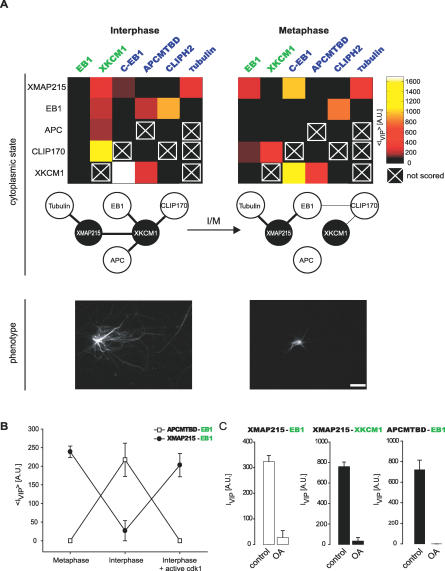
Change in the MAP Interaction Network at Interphase/Metaphase Transition(A) Pairwise interaction of MAPs in interphase and metaphase are represented as color-coded tables (upper panel). The color code corresponds to <IVIP> of at least three different microscopic fields. Proteins in green are EGFP tagged, and those in blue are Cy5 labeled. Below each table is a schematic representation of the network states in interphase and metaphase. Line thickness corresponds to interaction strength normalized to the strongest signal detected in interphase or metaphase. In the lower panel, an interphase aster is shown on the left and a mitotic one on the right(B) CDK1 activity induced a change in EB1-APCMTBD and EB1-XMAP215 interactions. EB1-EGFP fluorescence was measured simultaneously on beads coated with anti-XMAP215 and anti-APCMTBD antibodies in the presence of APCMTBD, and added to metaphase, interphase, and interphase extracts after addition of active, purified CDK1. Error bars represent the s.e.m. of <Ivip> measured in six different microscopic fields. A.U., arbitrary units.(C) XMAP215/EB1-EGFP interaction in metaphase (open bars) and XMAP215/XKCM1-EGFP and APCMTBD/EB1-EGFP interaction in interphase (filled bars) before (control) and after incubation with 10 μM okadaic acid (OA). Error bars represent the s.e.m. of <IVIP> derived from at least three different microscopic fields.